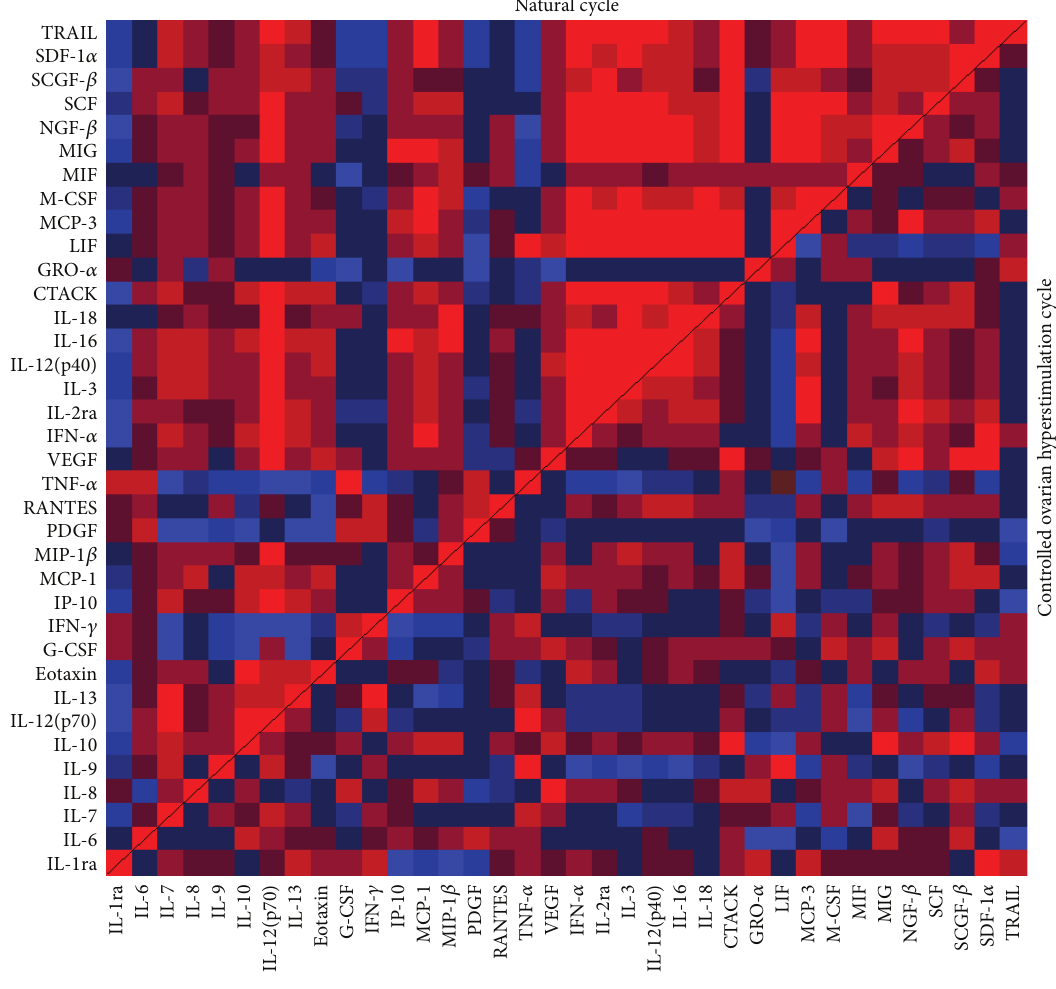
Figure 3: Heat maps demonstrating correlations between cytokines in periovulatory FF in MNC and COH cycles. Each square represents the correlation between specific cytokines: a red square represents a significantly positive correlation whilst a blue square represents a significantly negative correlation. A black square represents no significant relationship and the darker shades of red and blue represent weaker positive and negative correlations,